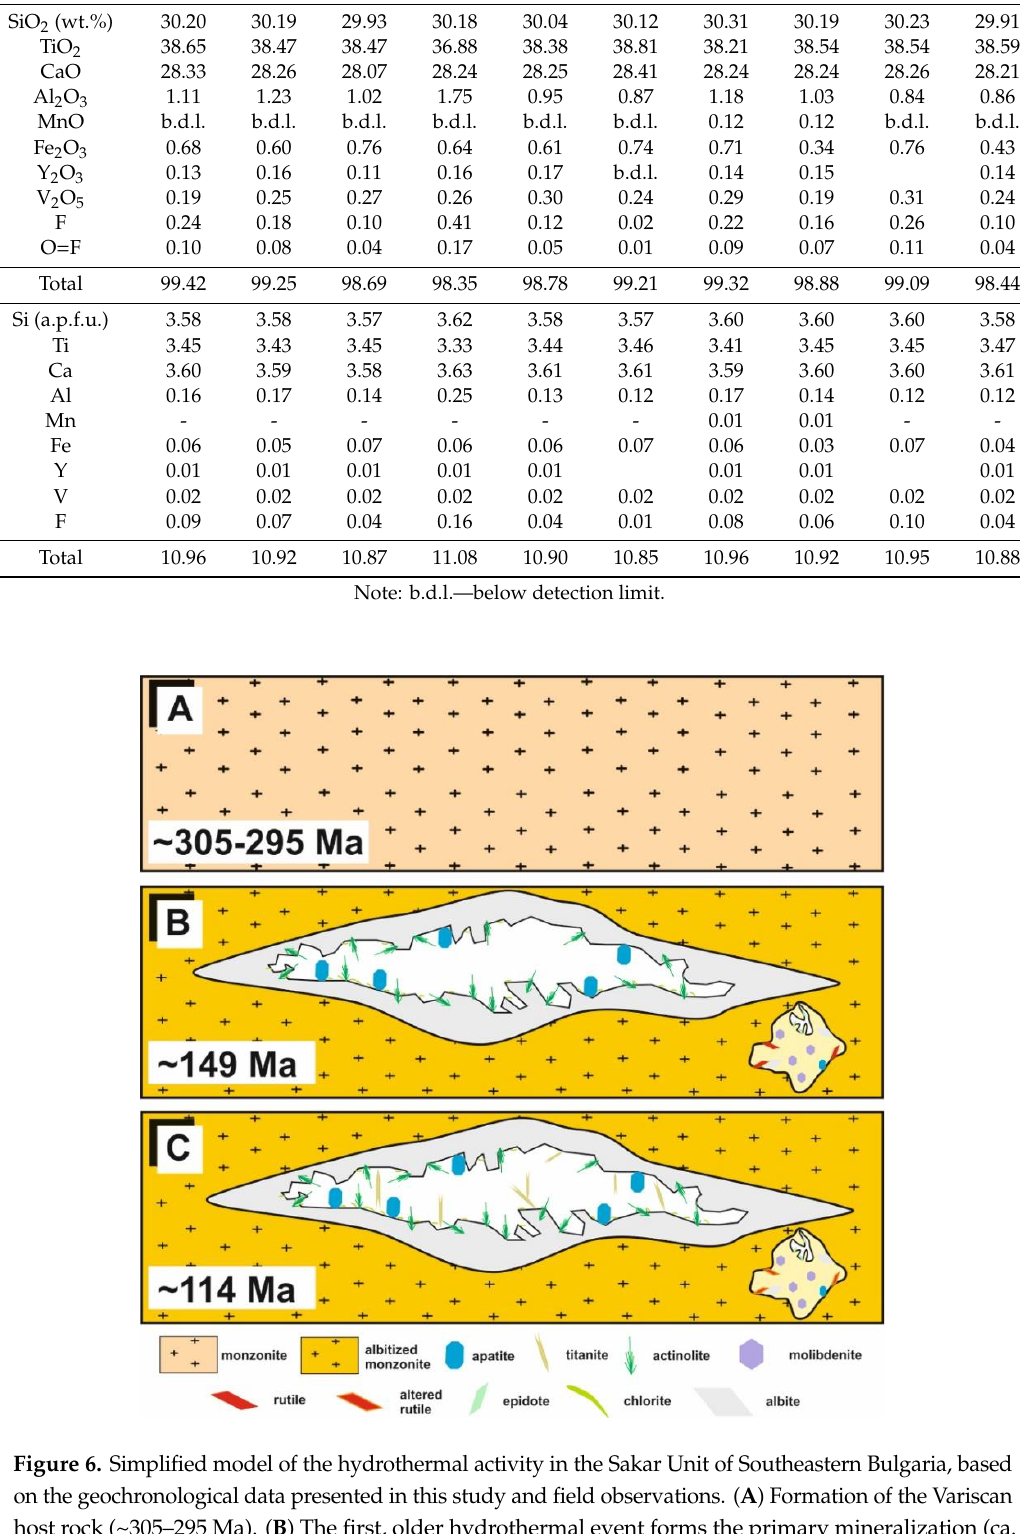
Table 2. Representative electron microprobe analyses (EMPA) of titanite and number of ion a.p.f.u. calculated on the basis of 18 O 2− of the investigated sample from the Kanarata quarry, Bulgaria. Compound 1 SiO 2 (wt.%)